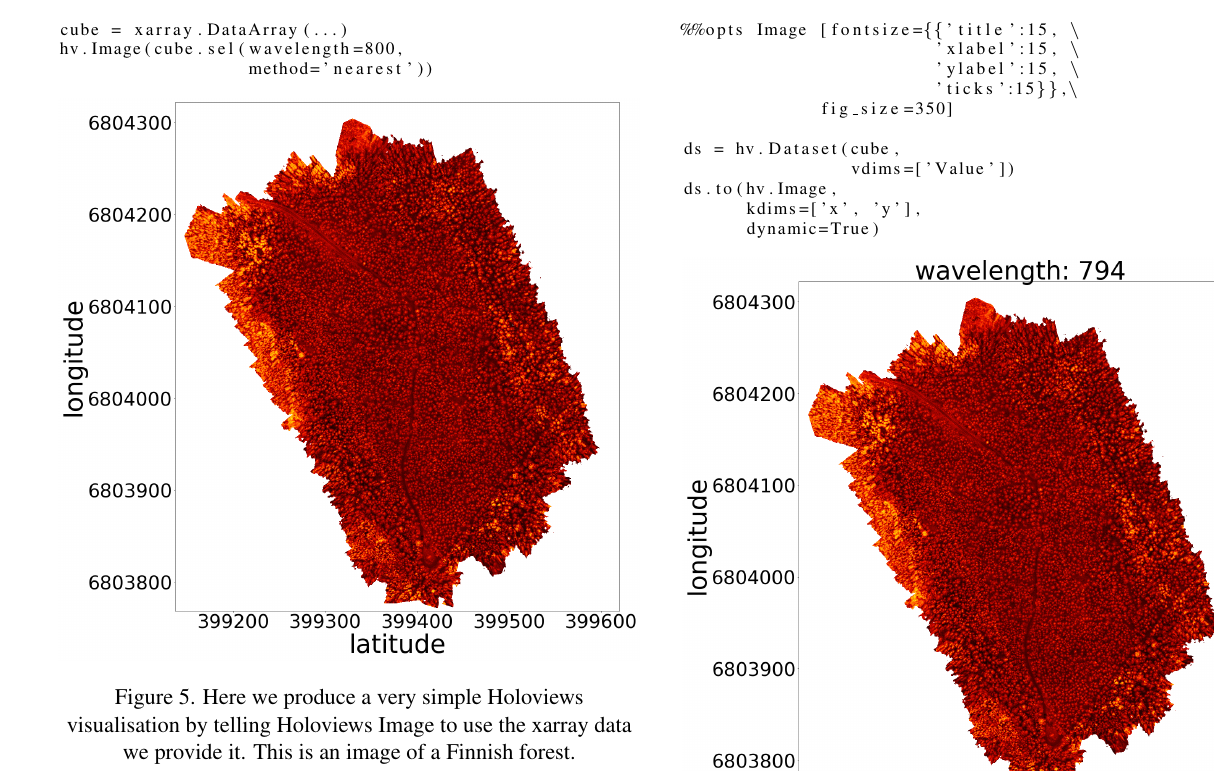
Figure 7. Extending xarray with a simple Accessor. Here